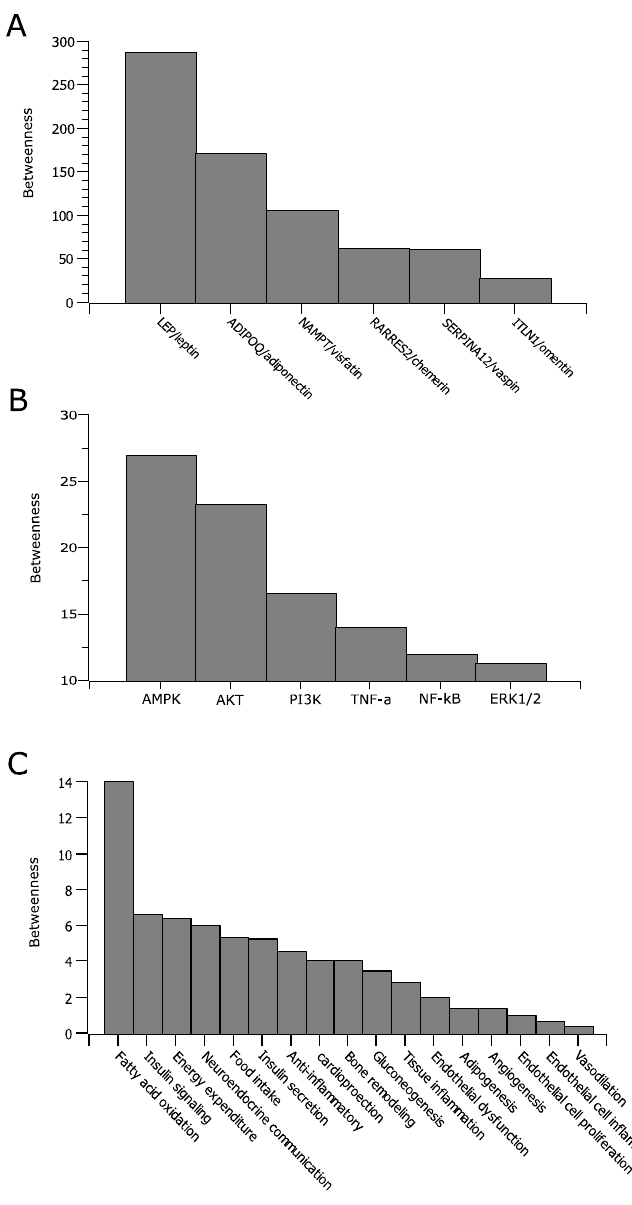
Figure 3. Betweenness centrality of the adipokine network, representing adipokines ( A ), molecular targets ( B ), and physiologic functions ( C ). Only selected molecular targets and physiologic functions are shown.